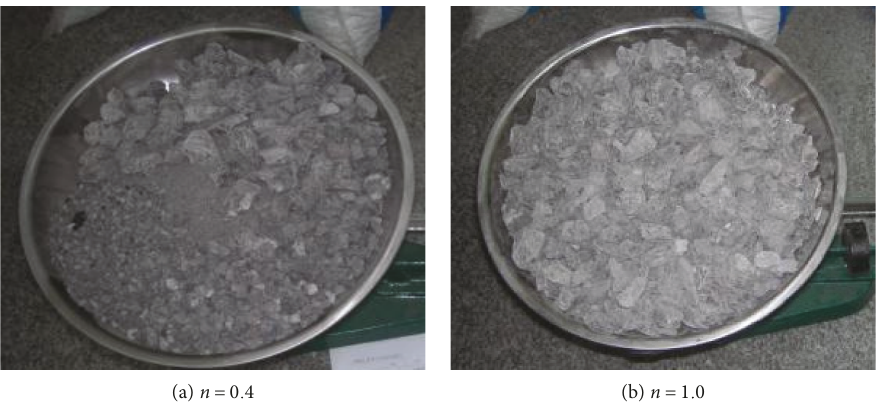
Figure 4: The test samples mixed according to Talbol continuous grading